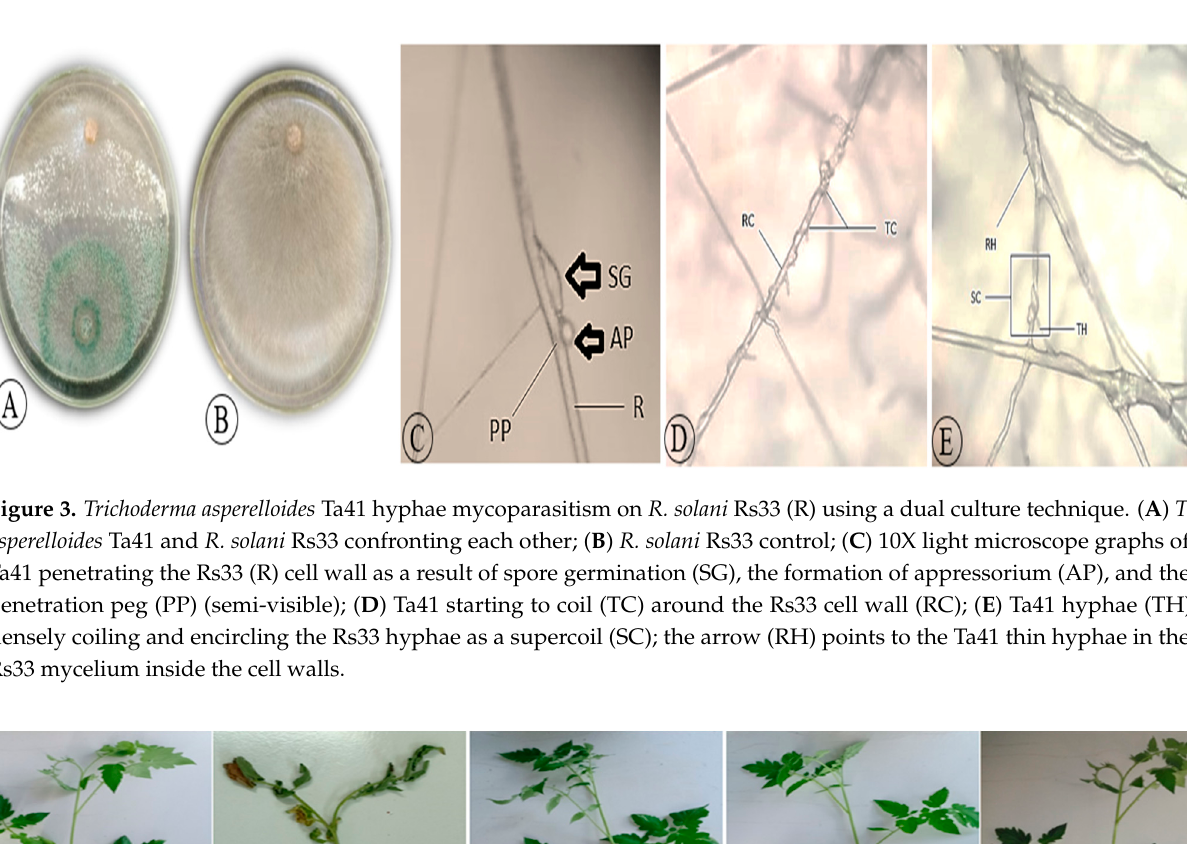
Rs33 mycelium inside the cell walls.